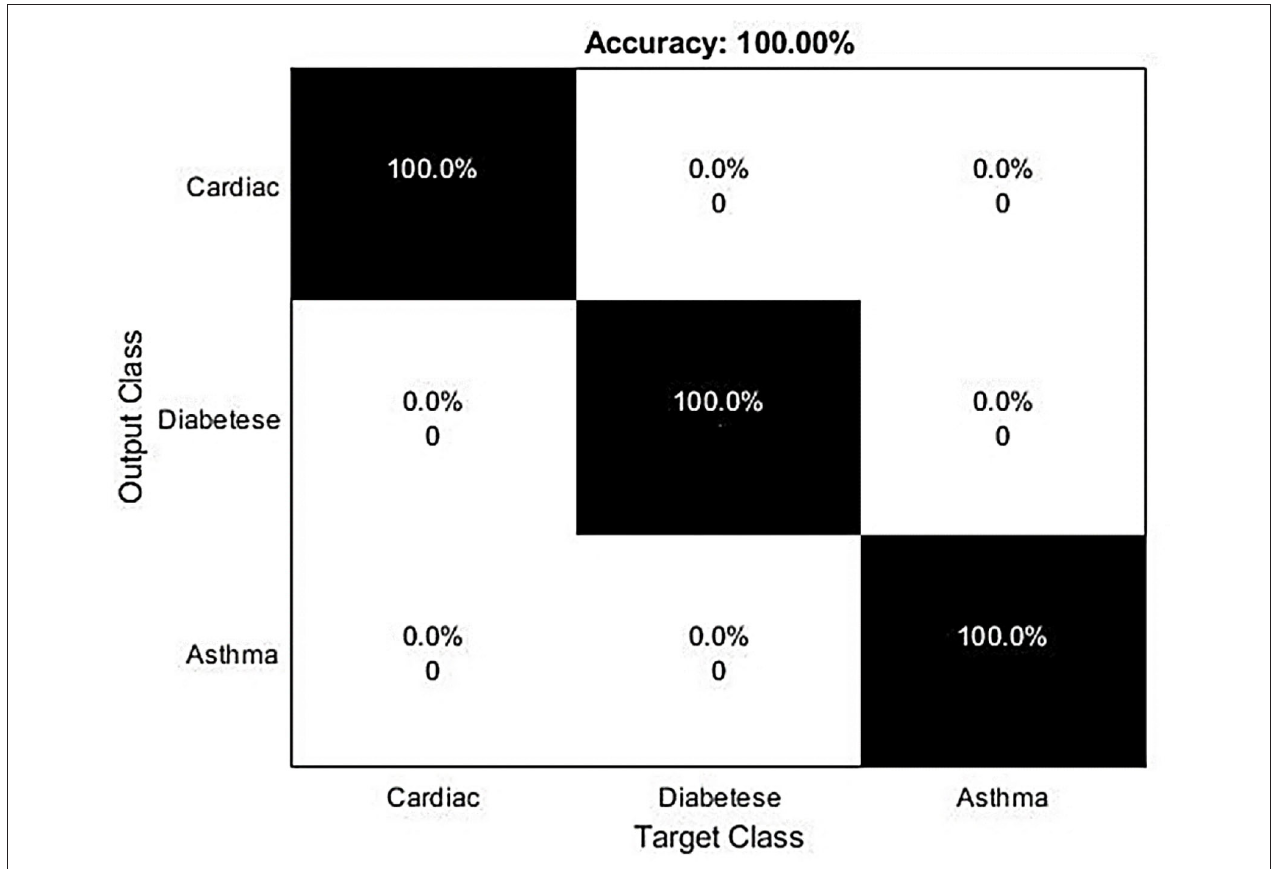
FIGURE 7 | Confusion matrix for severity-based analysis of the infected patients.